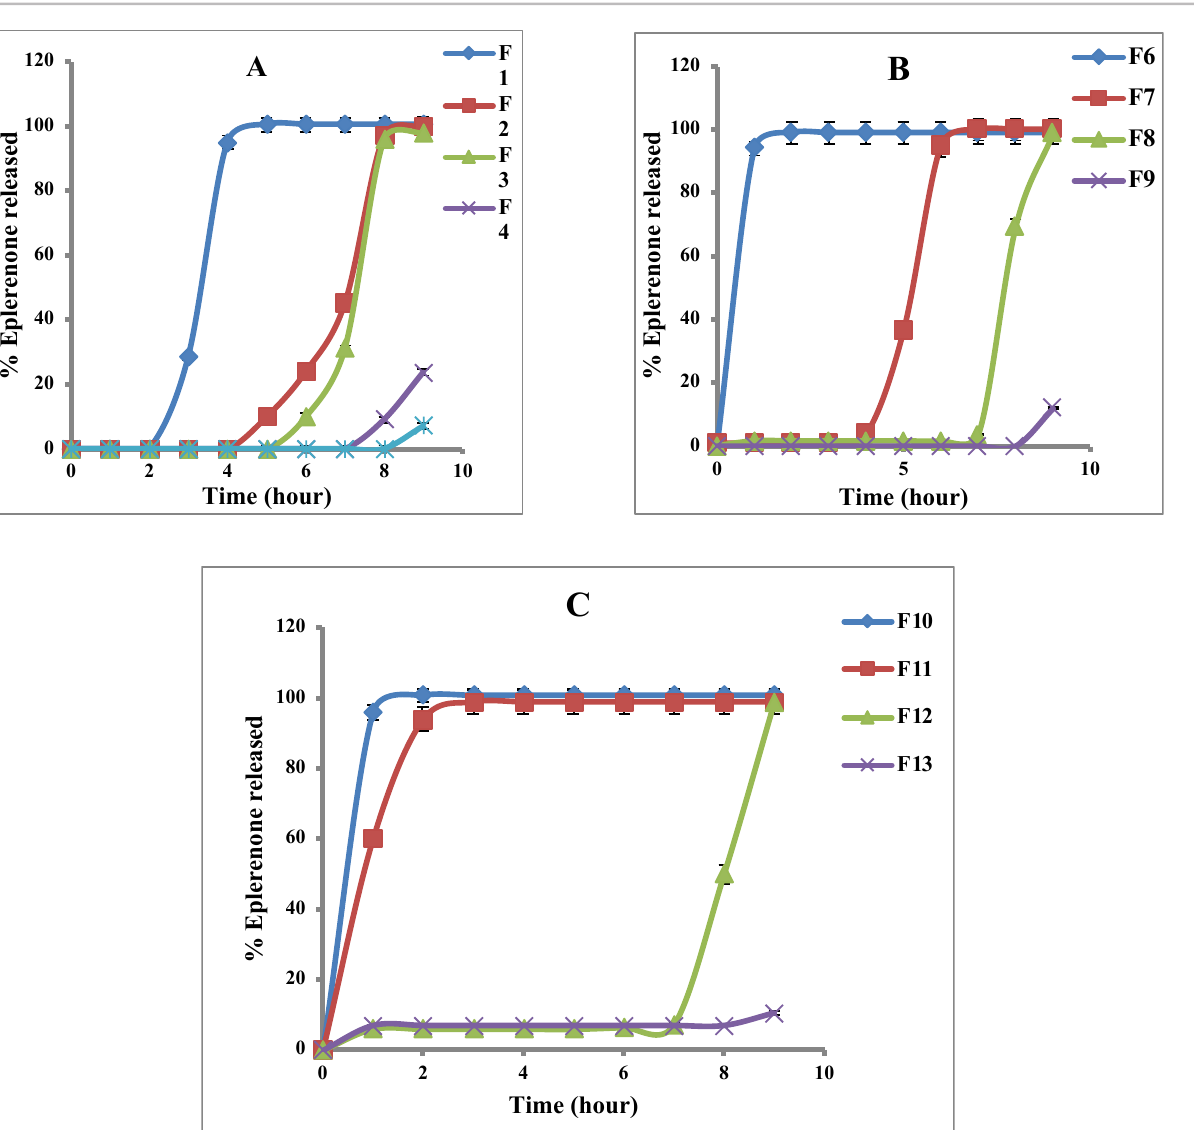
FIGURE 6 - (A-C) In-vitro release of Eplerenone from tablets coated with PEO WSR 1105 (F1- F5), Carbopol71G (F6- F9) and HPMC K 4M (F10- F13) respectively.